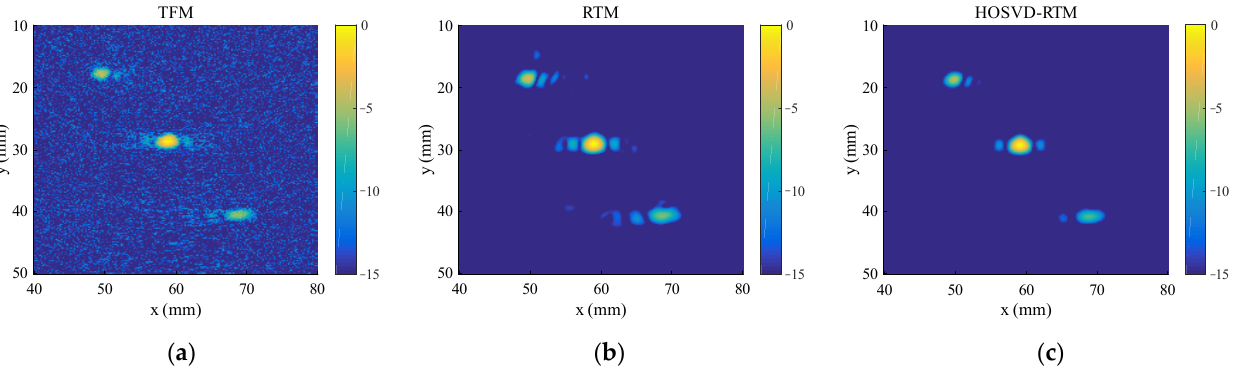
Figure 8. Simulated signal imaging results obtained with various algorithms. ( a ) TFM; ( b ) RTM; ( c ) HOSVD-RTM.